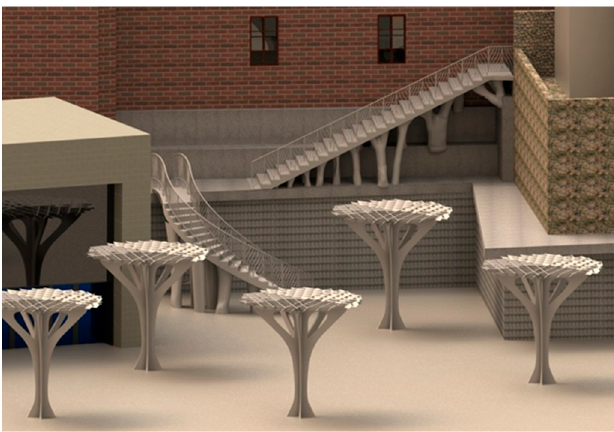
Figure 32. Digitally rendered model of the implementation of BIM construction elements in the urban